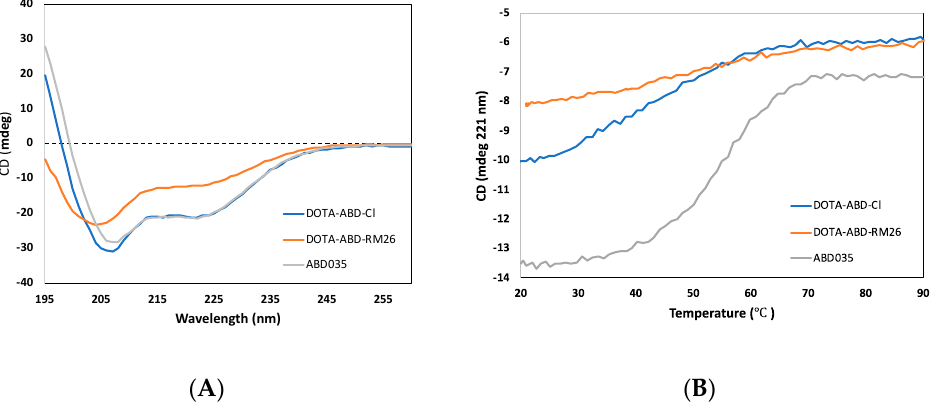
Figure 2. Circular dichroism (CD) spectra ( A ) and thermal melting curves ( B ) of DOTA-ABD-RM26, DOTA-ABD-Cl and ABD035.